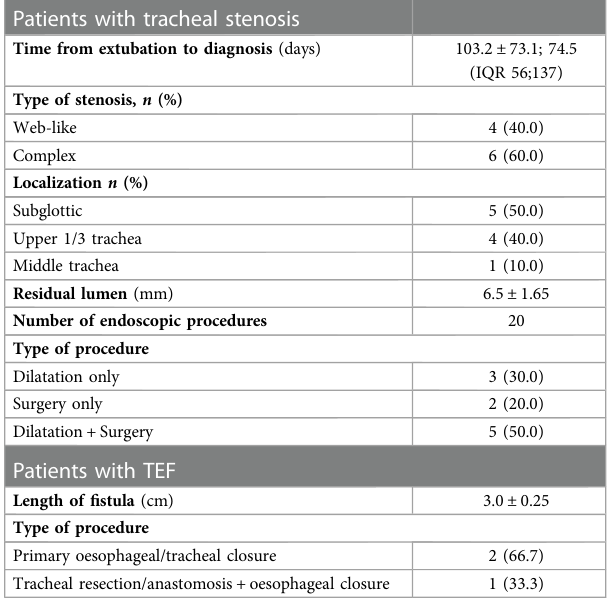
TABLE 2 Bronchoscopic features of patients ’ tracheal stenosis and/or TEF. Patients with tracheal stenosis